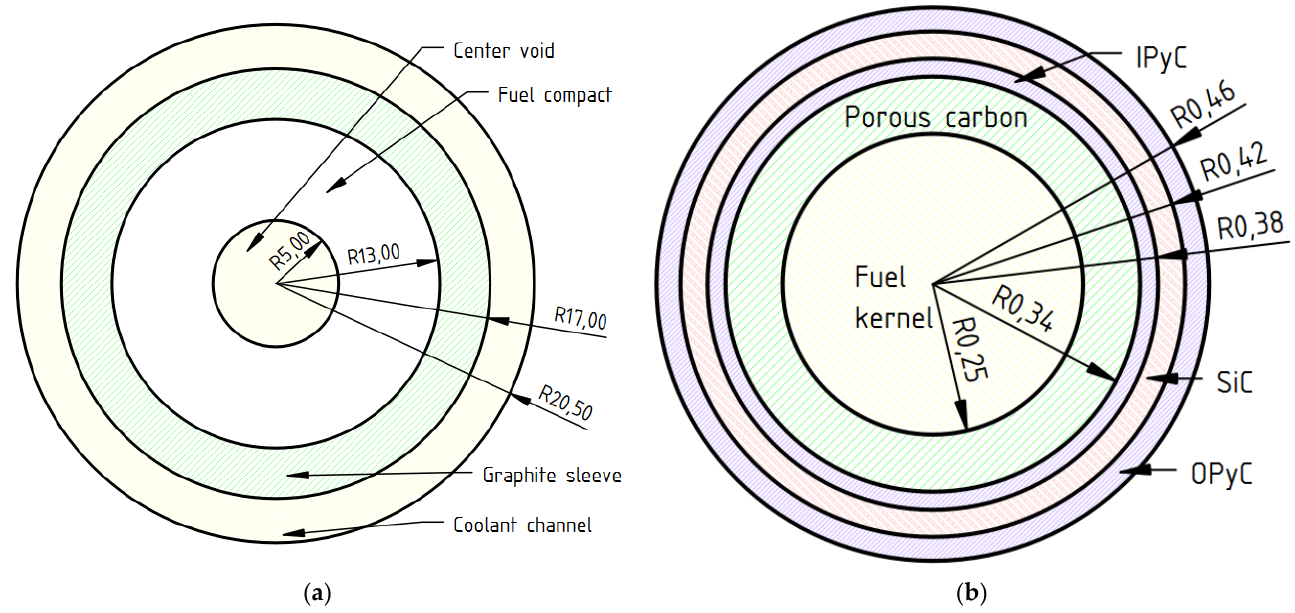
Figure 1. Structure of ( a ) fuel rods and ( b ) TRISO particles. Dimensions are given in mm.